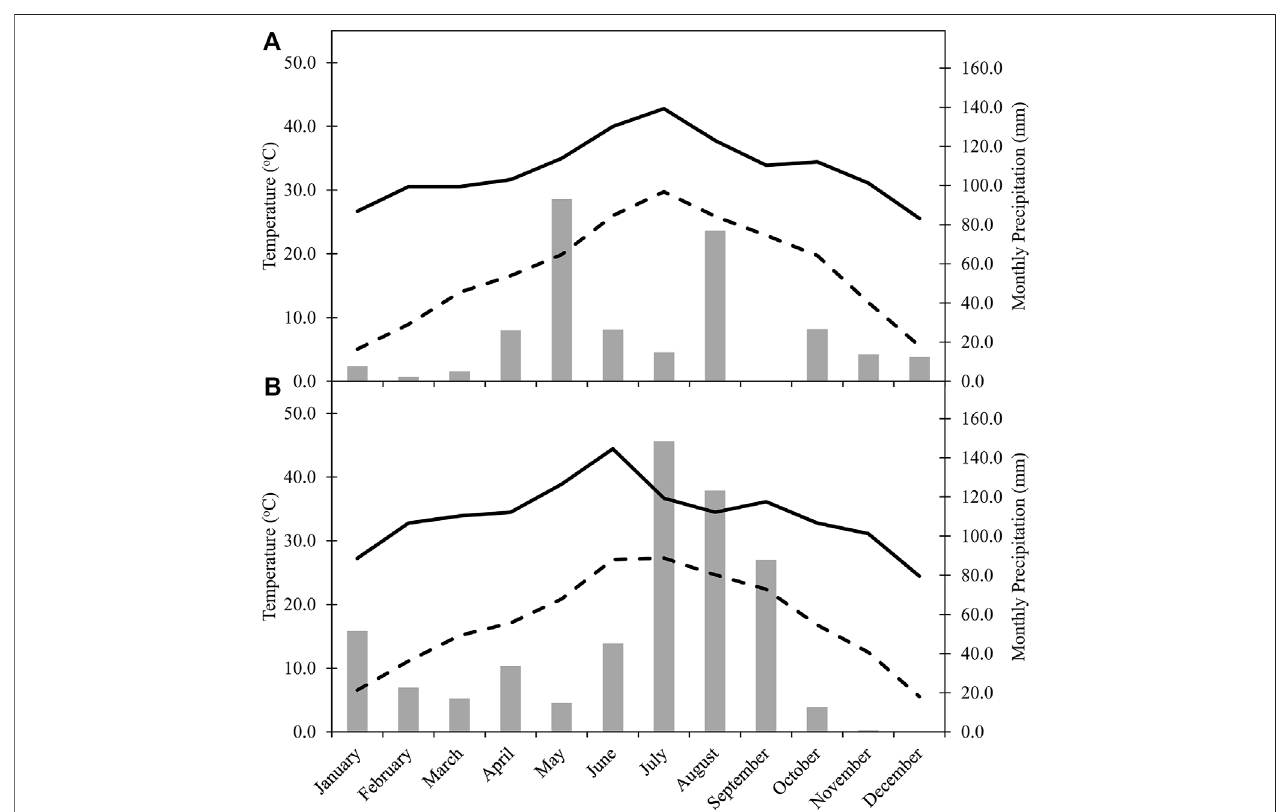
FIGURE 1 | Monthly maximum temperature ( ° C), monthly mean temperature ( ° C), and monthly cumulative precipitation in (A) 2016 and (B) 2017. Data was collected from the National Oceanic and Atmospheric Administration weather station 2 km south of the research site at the Lubbock International Airport, TX, United States